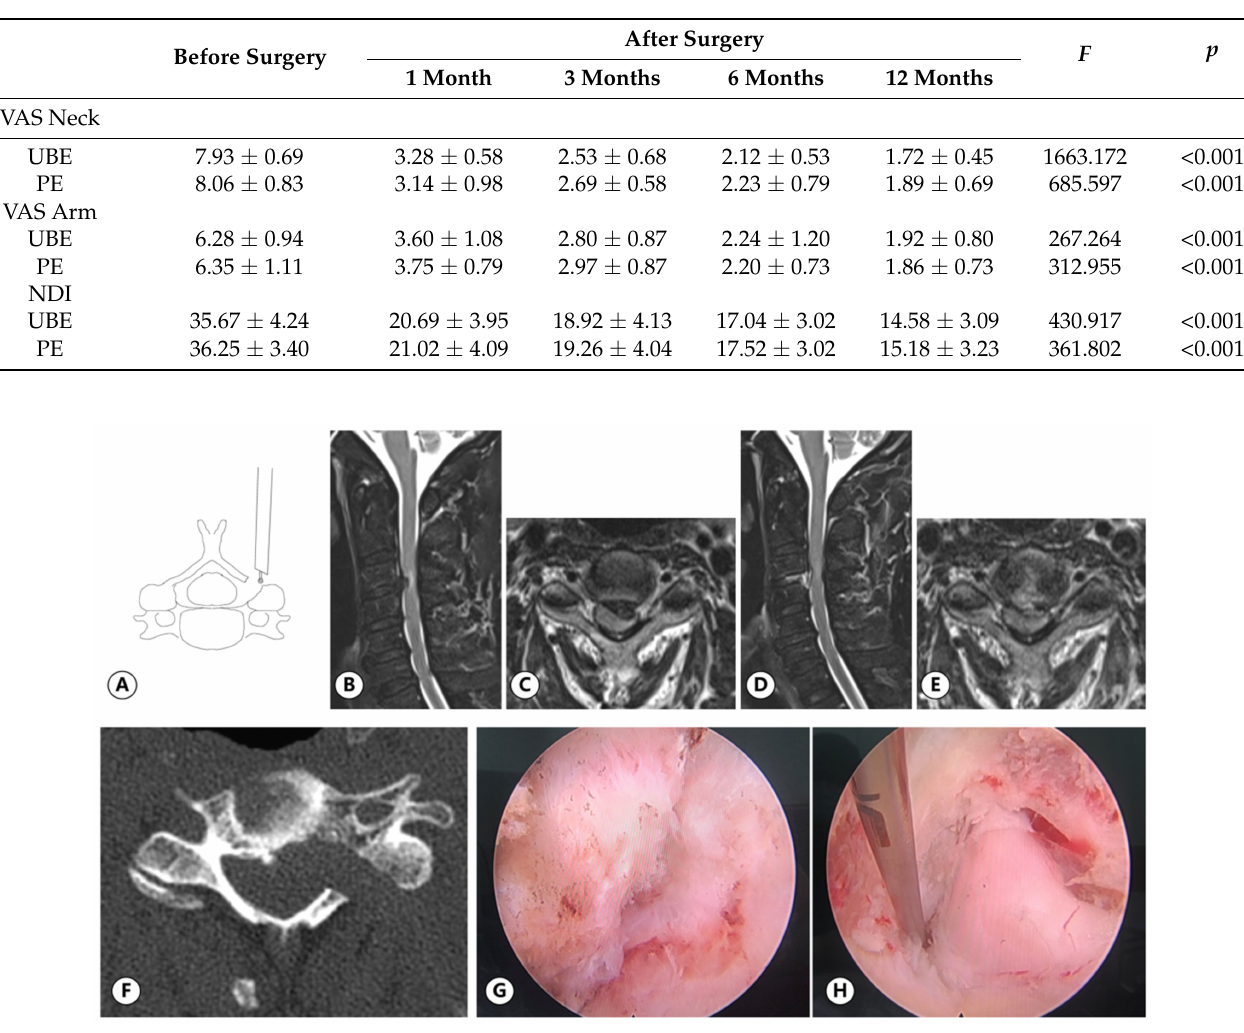
Table 3. VAS and NDI scores before and after surgery.